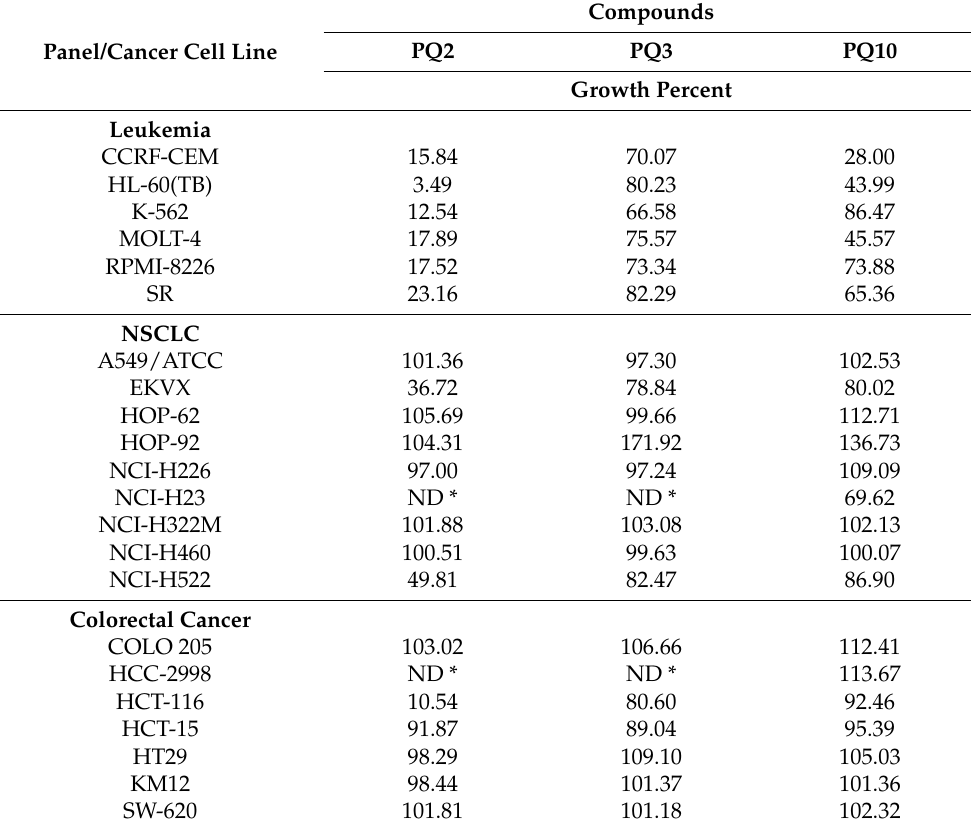
Table 2. Antiproliferative activity data as per single-dose assay at 10 µ M concentration as cell growth percent of PQ analogs. All experiments were repeated one